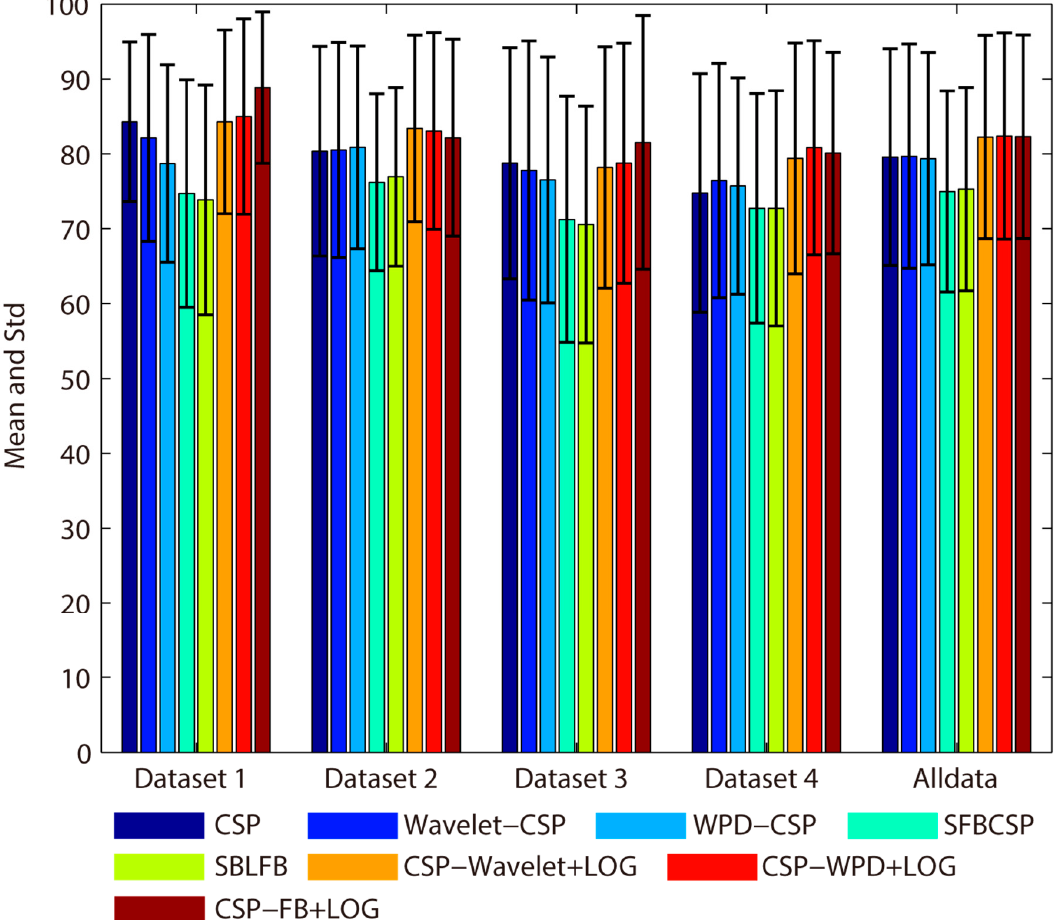
Figure 7. Average classification accuracy comparison (all data). Table 6. The effect of secondary feature selection on average classification accuracy of various datasets (the LASSO method).